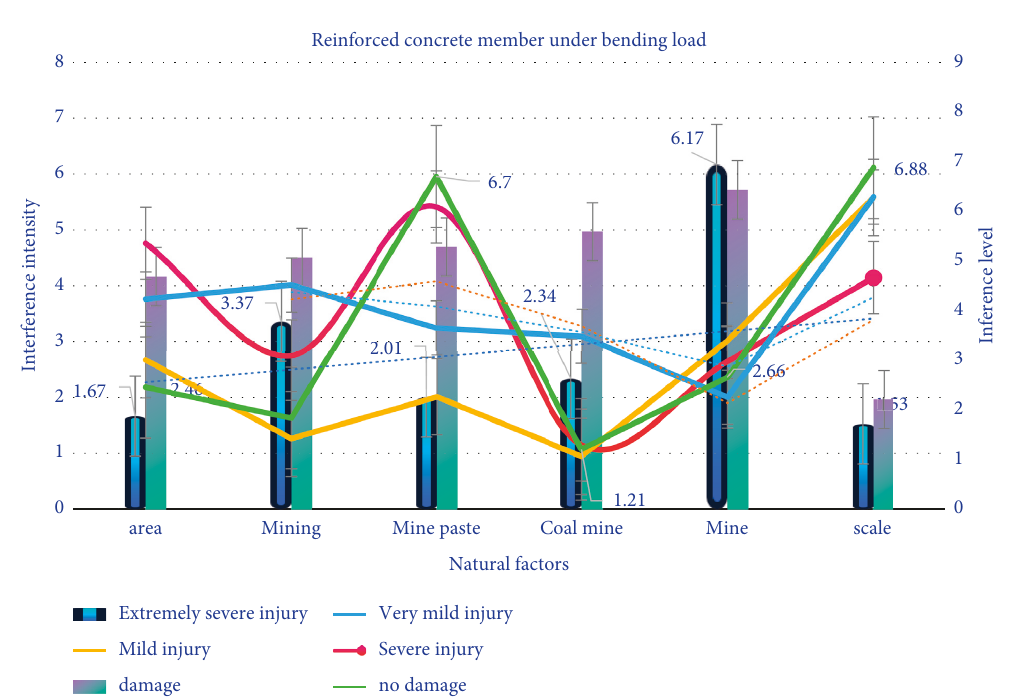
Figure 9: Reinforced concrete member under bending load.